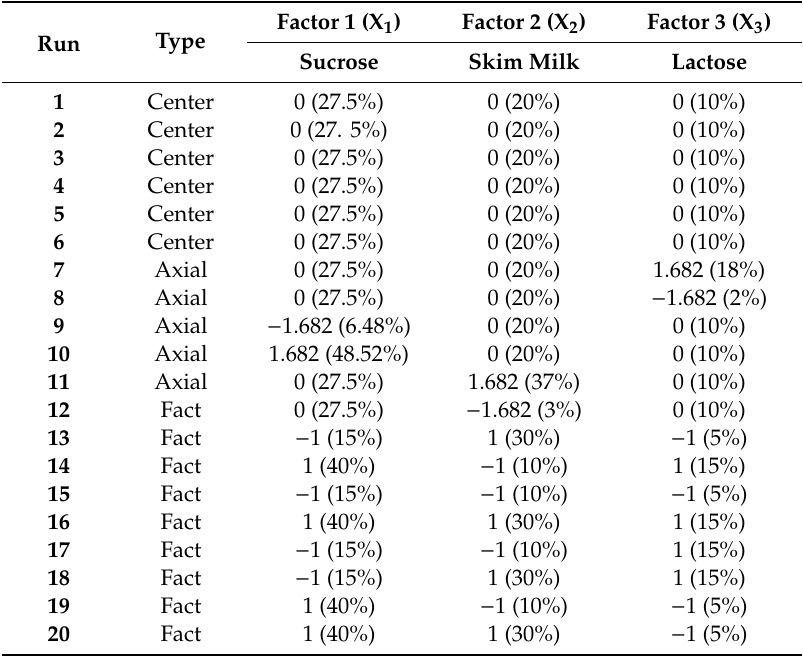
Table 5. Protective agent combination based on a central composite design